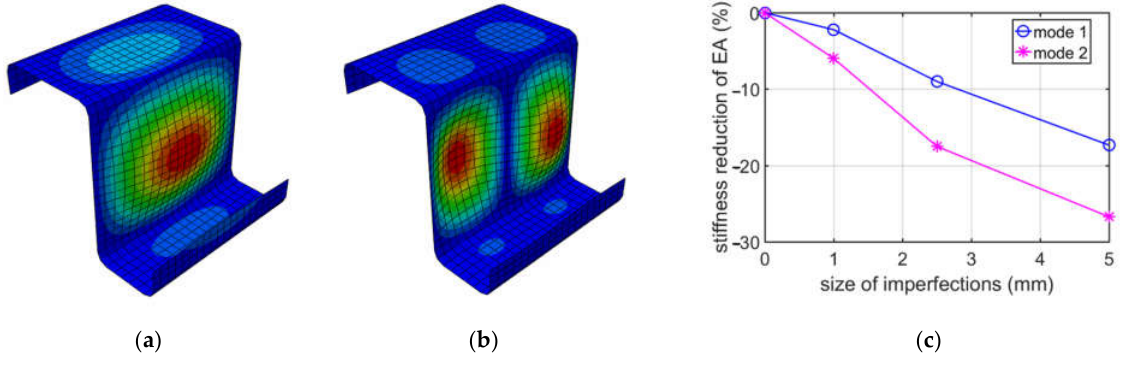
Figure 4. Buckling in compression for 100 mm depth: ( a ) mode 1; ( b ) mode 2; ( c ) plot of the stiffness reduction of EA, depending on the size of imperfections.